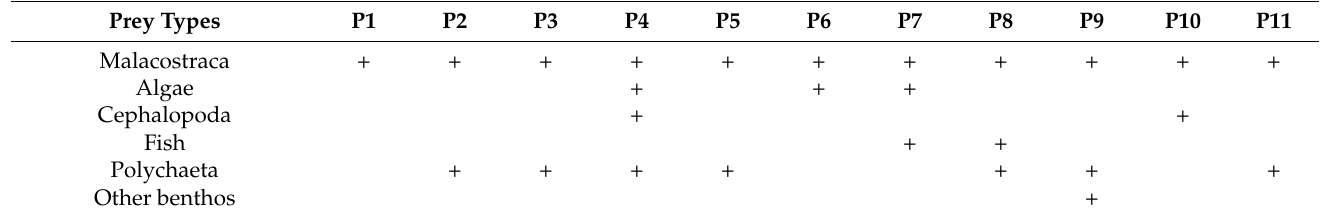
Table 4. Prey items of M. caml are determined by morphological analyses; ‘+’ represents occurrence of the prey types. P1 to P11 refers to sample 1 to sample